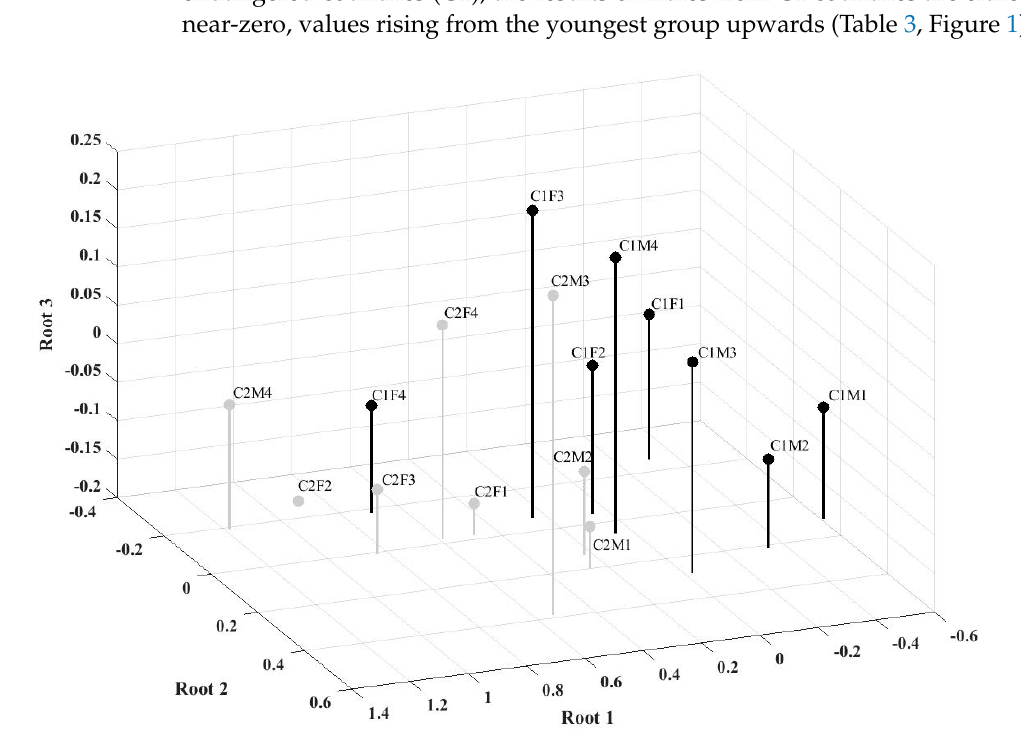
Figure 1. Centroids representation on first, second, and third discriminant functions. Note: Country: C1 and C2. Gender: M, F. Age groups: 1—emerging adults 18–25 years, 2—young adults 26–39 years, 3—middle-aged adults 40–59 years, and 4—elderly of 60 years and more.